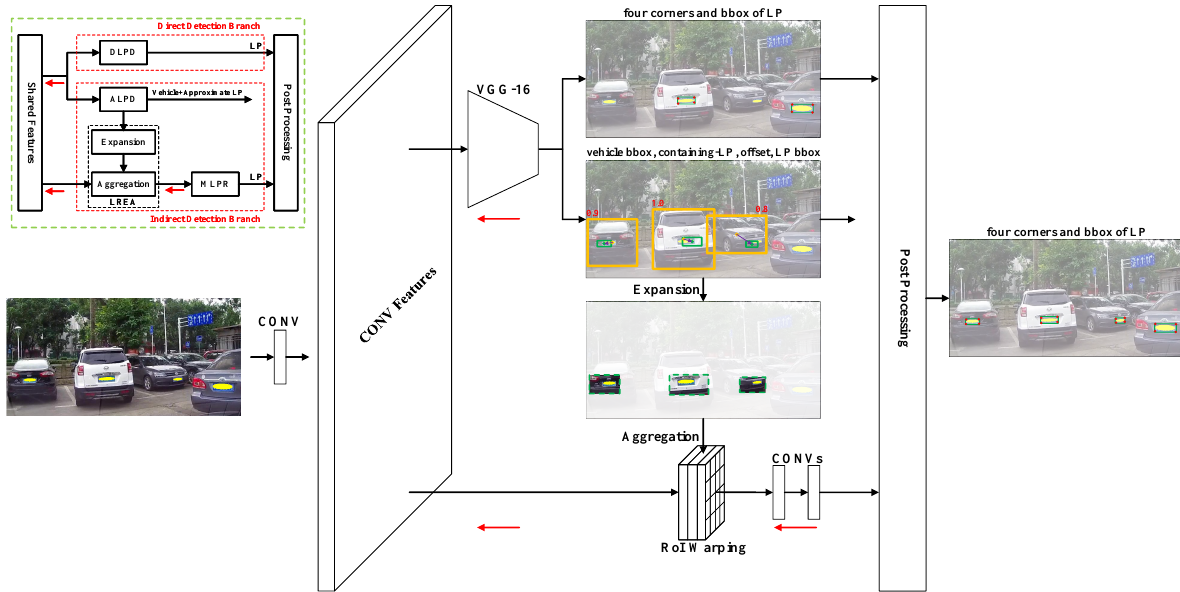
Figure 2. A thumbnail of the overall architecture is shown in the top-left corner (DLPD: Direct License Plate Detection; ALPD: Approximate License Plate Detection; LREA: Local Region Estimation and Aggregation; MLPR: Multidirectional License Plate Refinement). All the recognizable license plates are manually covered with a yellow ellipsoid to protect